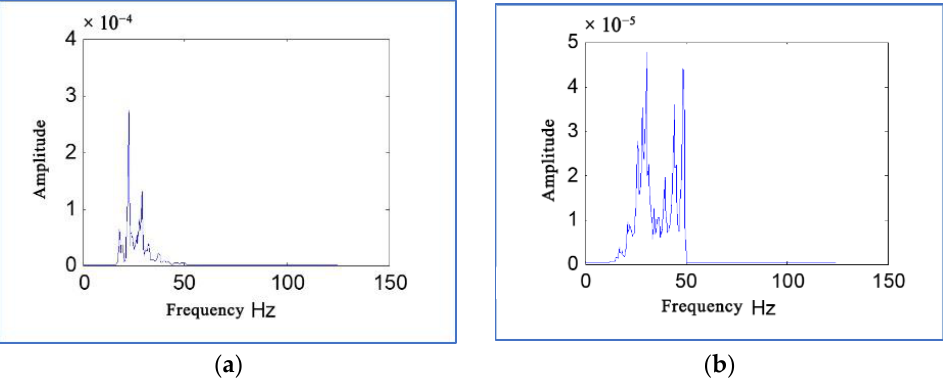
Figure 4. Testing spectrum under train vibration load. ( a ) is Speed 60 km/h; ( b ) is Speed 120 km/h.